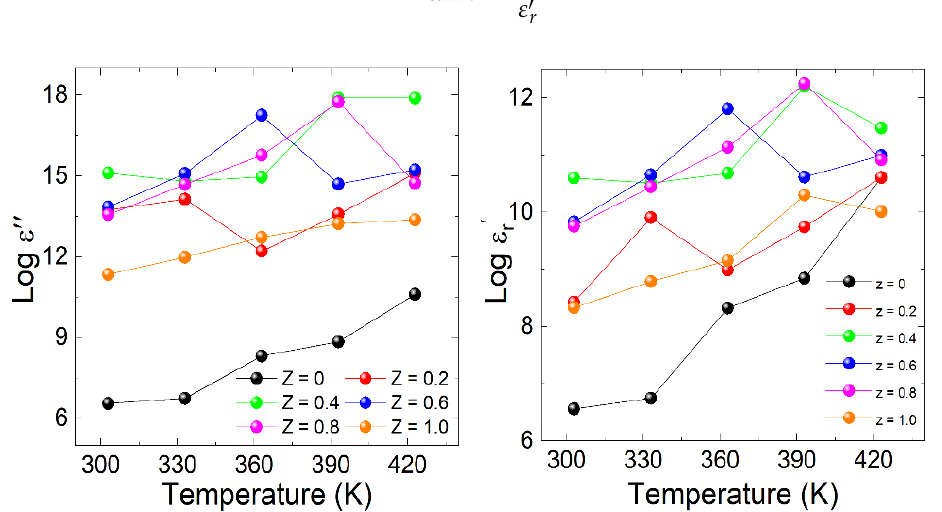
Figure 9. The variation of the real part of the dielectric constant ( Log 𝜀 𝑟′ ) ( left side) and Imaginary part of dielectric ( Log ε’’ ) ( right side) for La 2 Co 1−z Fe z MnO 6 (z = 0, 0.2 – 1.0). The dissipation of energy (tan δ ) shows maximum values with the temperature in- crease at low frequencies. The tan δ has a higher value compared to the energy stored at low frequencies. The tan δ decreased with increasing frequency due to the attributed charges to the field [37]. The variations in tan δ were observed with frequency for different concentrations of iron. The dielectric loss increased with increasing the concentration, and temperature variation is also shown in each inset of Figure 10a–f. The energy losses may be attributed to the collision, vibration, and other charges’ phenomena. Moreover, the loss is related to the period difference between relaxation and the applied field. Low relaxation time results from the instantaneous polarization process while large relaxation time is associated with the delayed polarization process. When the applied field has the same period of relaxation, the loss contribution is at its maximum. Losses turn smaller when the relaxation time greatly differs between the period of the applied field. The loss becomes small if the relaxation time is relatively larger than the applied field frequency. In this situation, the polarization mechanism is much slower than the reversal of the field, which cannot make ions follow the applied field. Similarly, if the relaxation time is much smaller than the applied field frequency, the polarization process can easily follow the applied field with no lag, creating a small